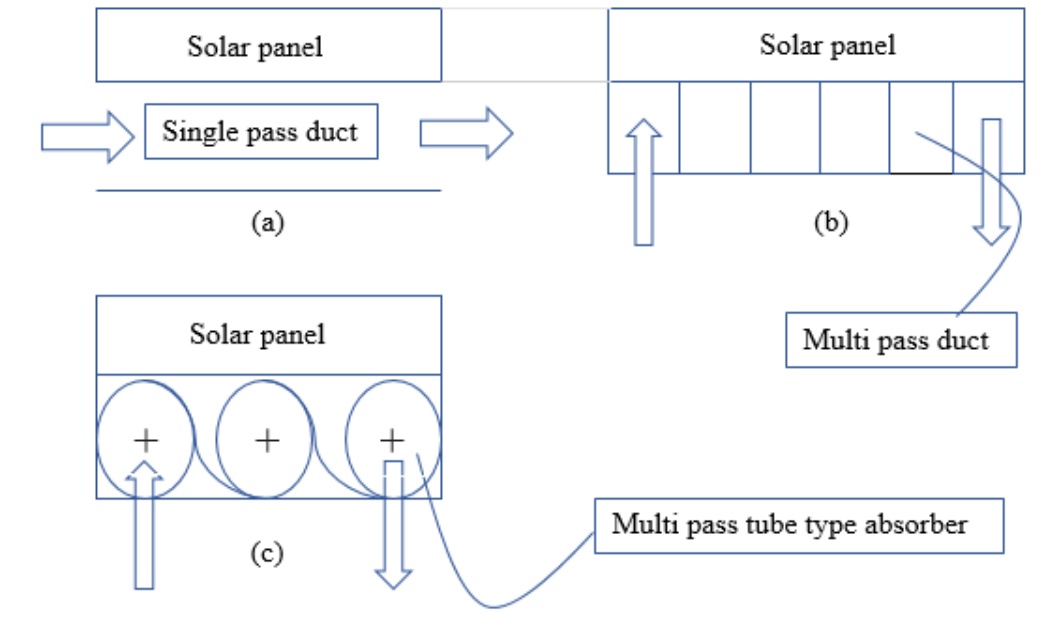
Figure 2. Heat absorber layouts: ( a ) single-pass duct; ( b ) multi-pass duct; ( c ) tube-type absorber.